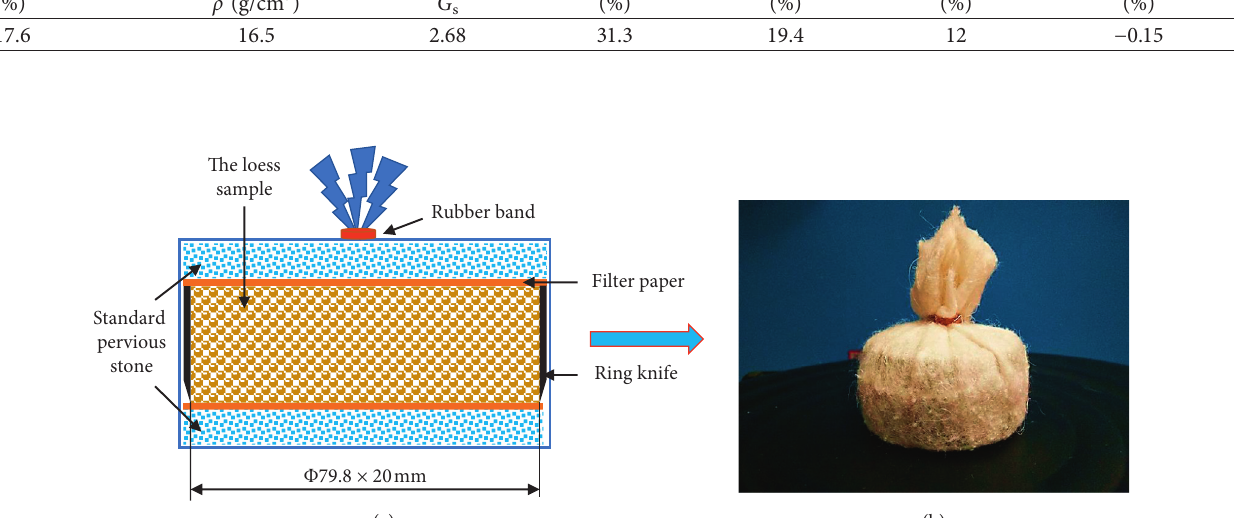
Figure 1: Schematic diagram of sample and object. (a) Test soil sample design. (b) Sample